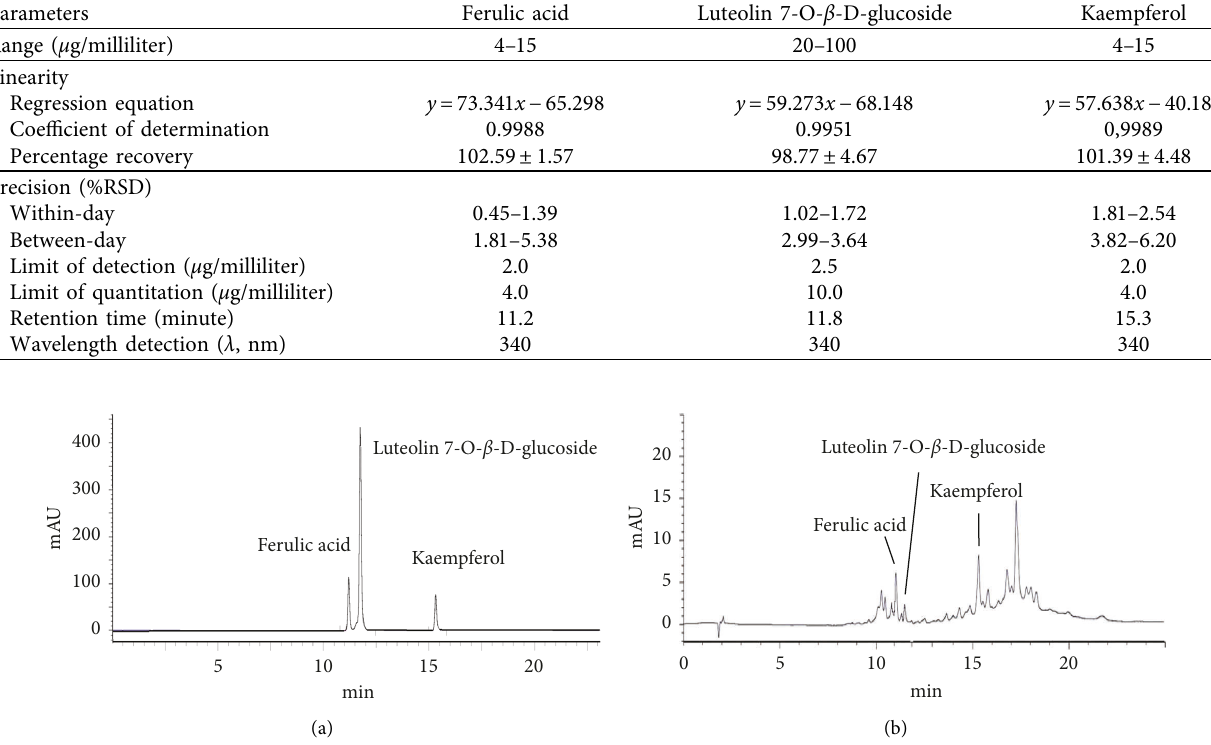
Figure 2: HPLC chromatograms of standard ferulic acid, luteolin 7-O- β -D-glucoside, and kaempferol solutions (a) and the fingerprint